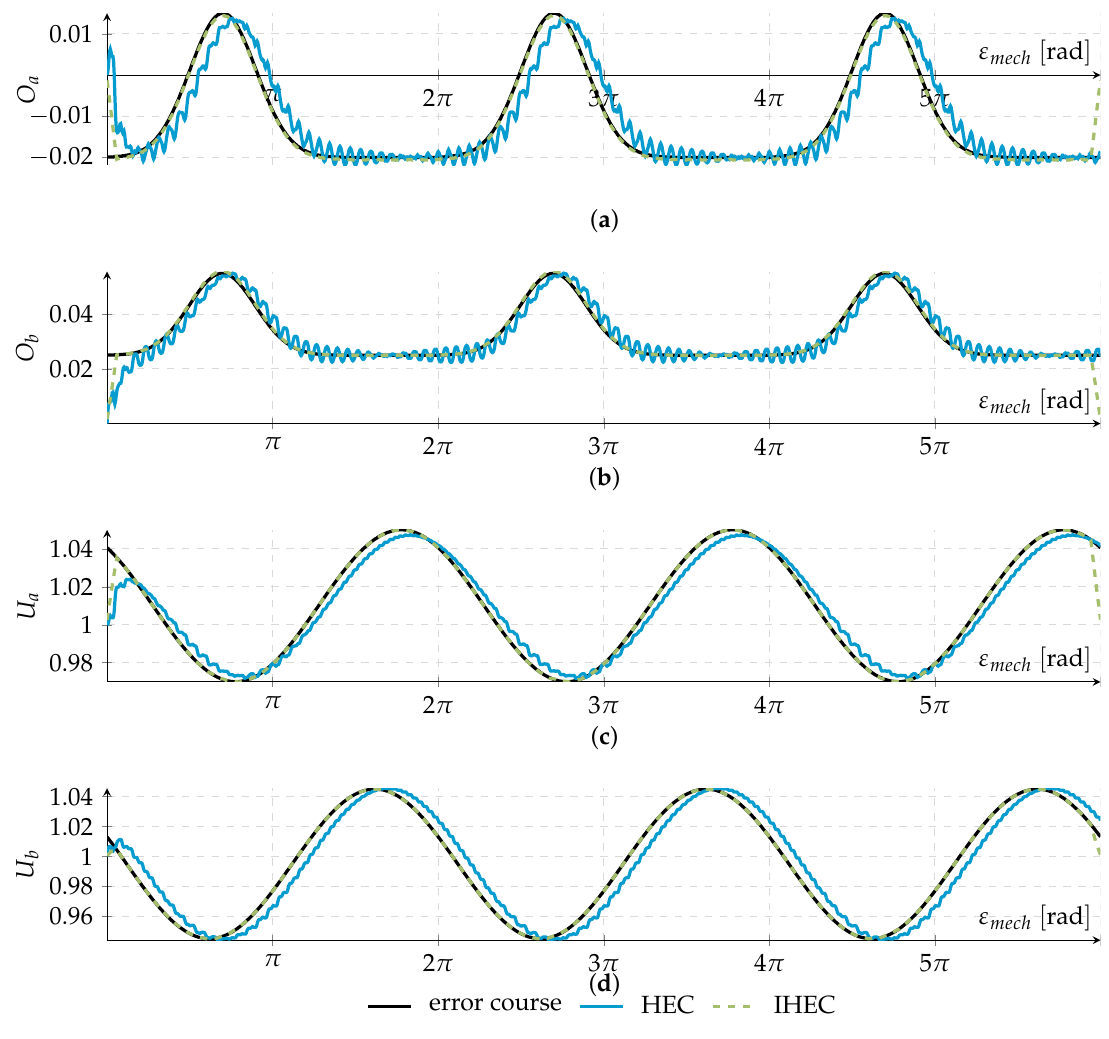
Figure 8. Simulation results for parameter variation over one revolution of ( a ) the offset of line A ; ( b ) offset of line B ; ( c ) amplitude of line A and ( d ) amplitude of line B of both estimation methods.